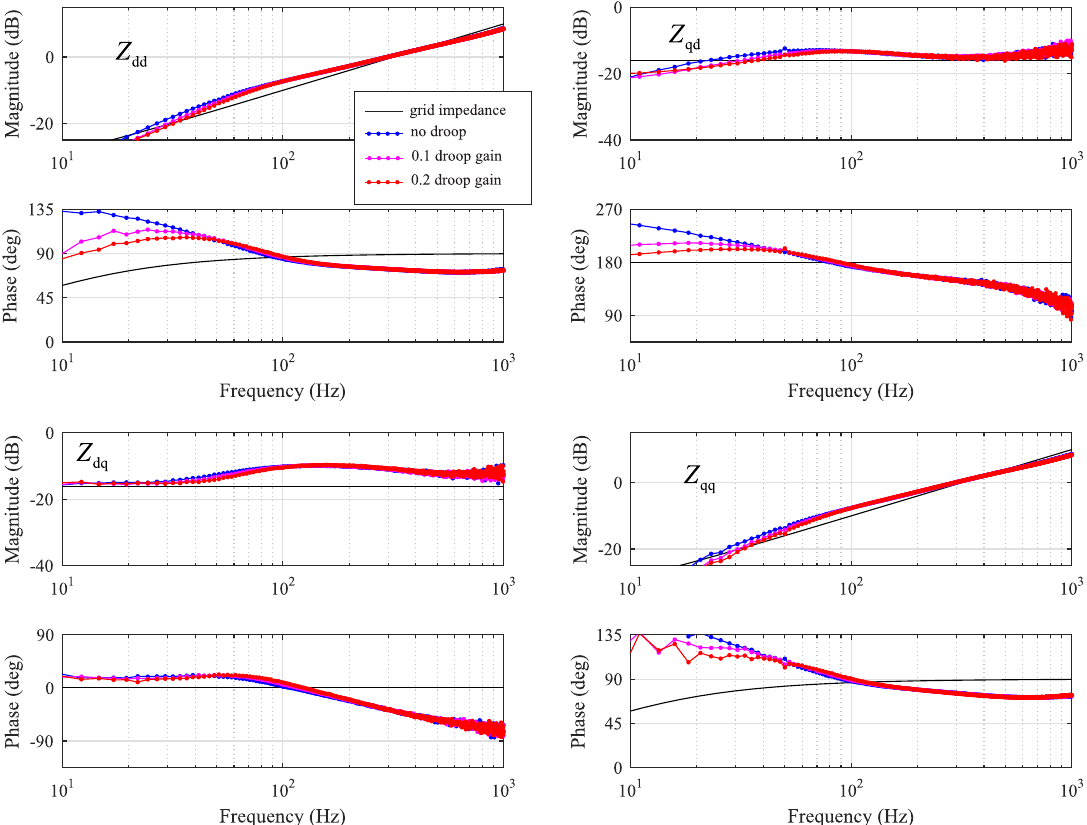
Figure 15. Measured impedancewith parallel-connected device with additional voltage control and